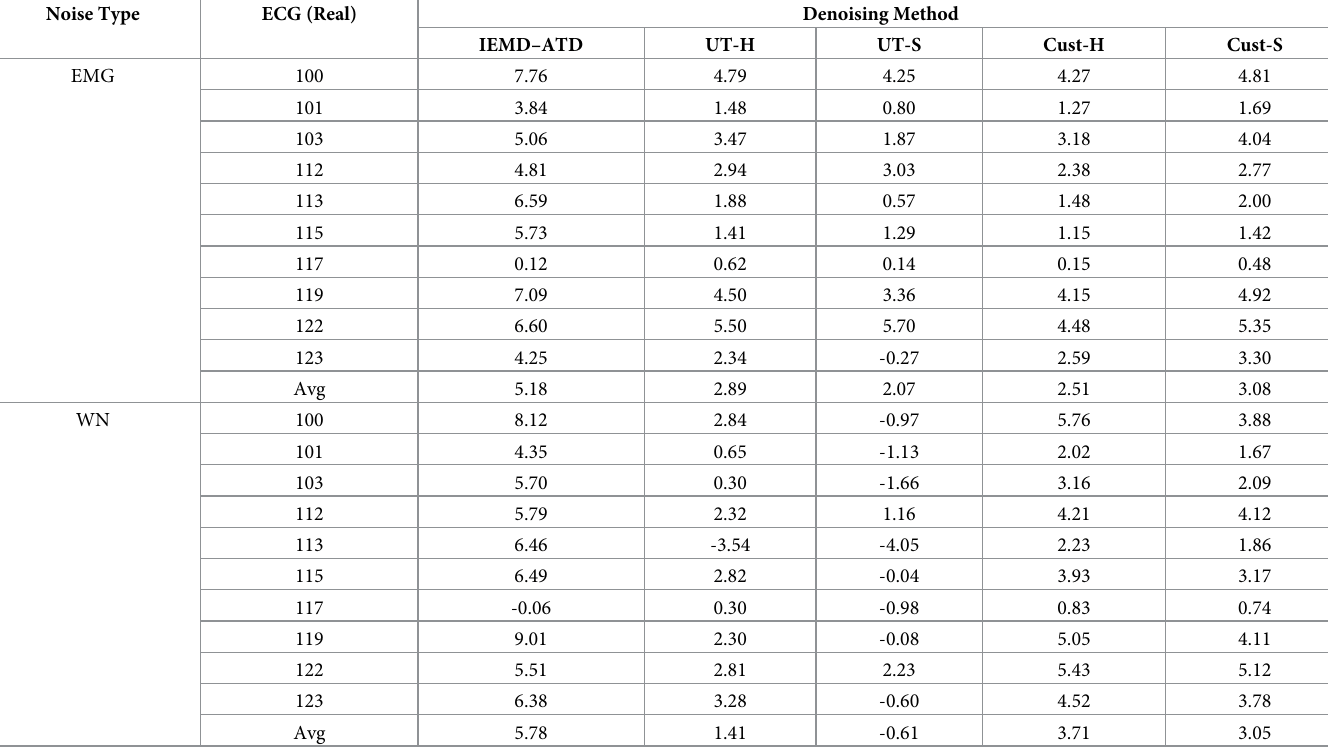
figure, IEMD-ATD offers the best denoising performance for cleaner, clearer and more intact QRS waveforms. SNR improvements of the 5 denoising methods for 10 real ECGs are displayed in Table 11 . The original SNR of the noisy ECG is 5 dB. The noises used here are EMG and WN. “Avg” in Table 11. SNR improvement of 5 denoising methods for real ECGs contaminated with EMG and WN at 5 dB. Noise Type ECG (Real) Denoising Method